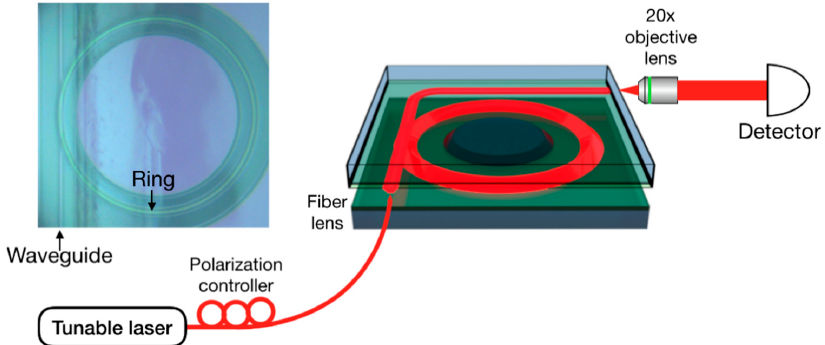
Figure 2. Schematic of the experimental setup for measuring the Q factor of the microring resonator. Left inset: Optical micrograph image of the microring resonator coupling with the waveguide, as indicated by the black arrows.